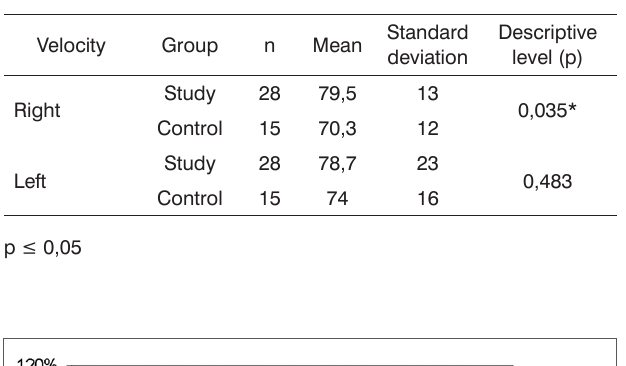
Table 3. Comparing the randomized saccade movements between the groups.